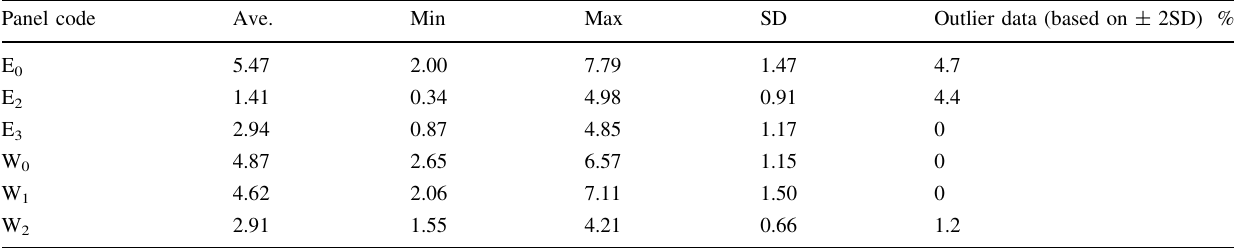
Table 6 Description of FAR for considered panels in Parvadeh-I coal mine Panel code